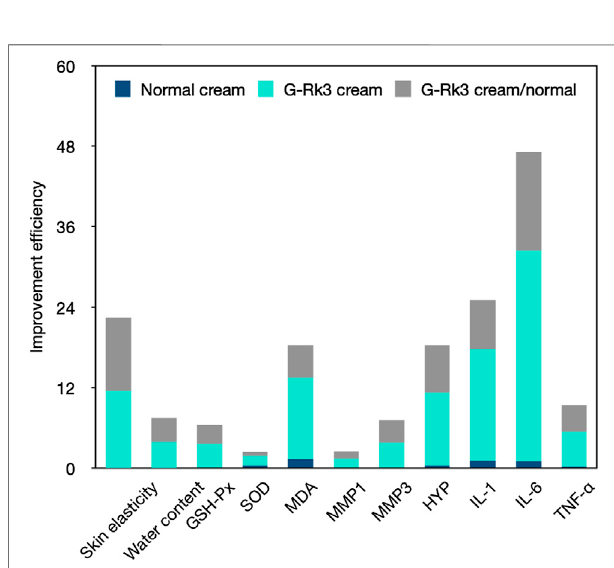
FIGURE10| Comprehensive comparison oftheanti-photoagingeffects of the G-Rk3 cream and normal cream.